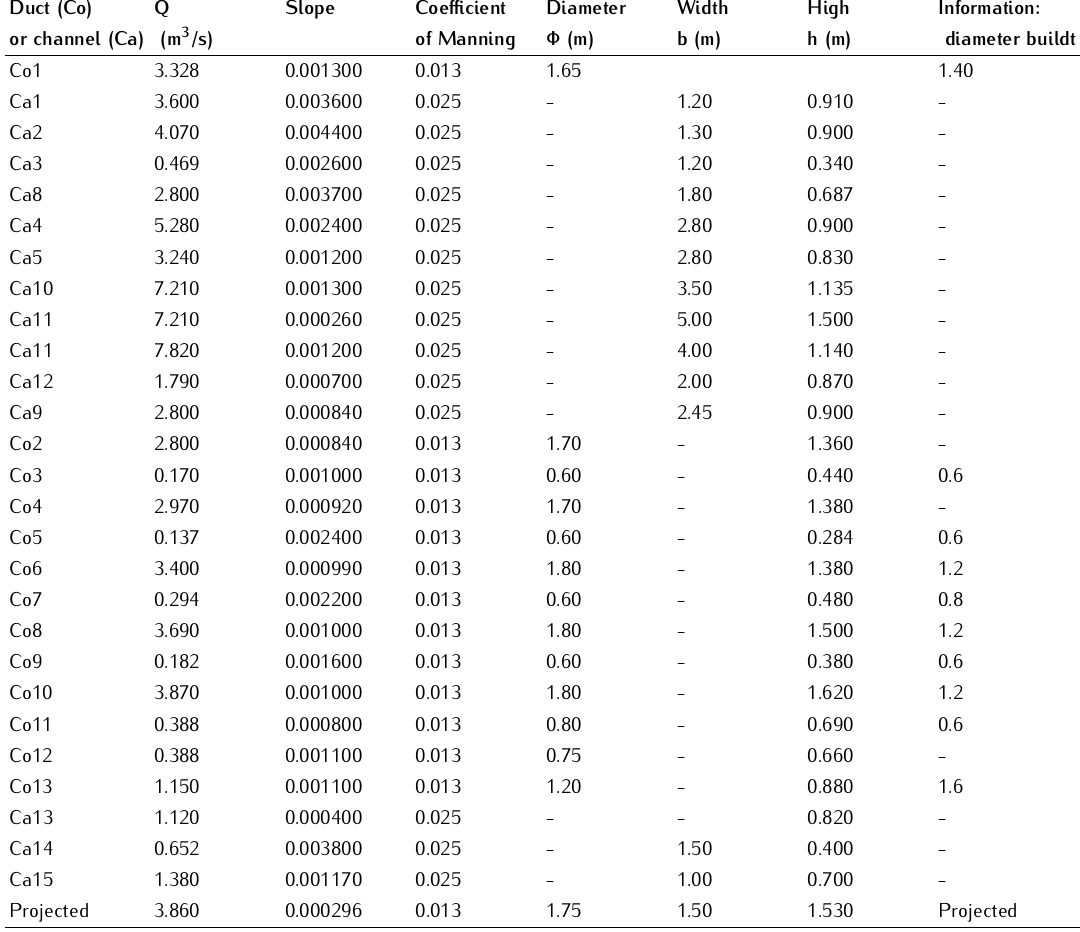
Table 4. Results obtained of calculation of ducts and